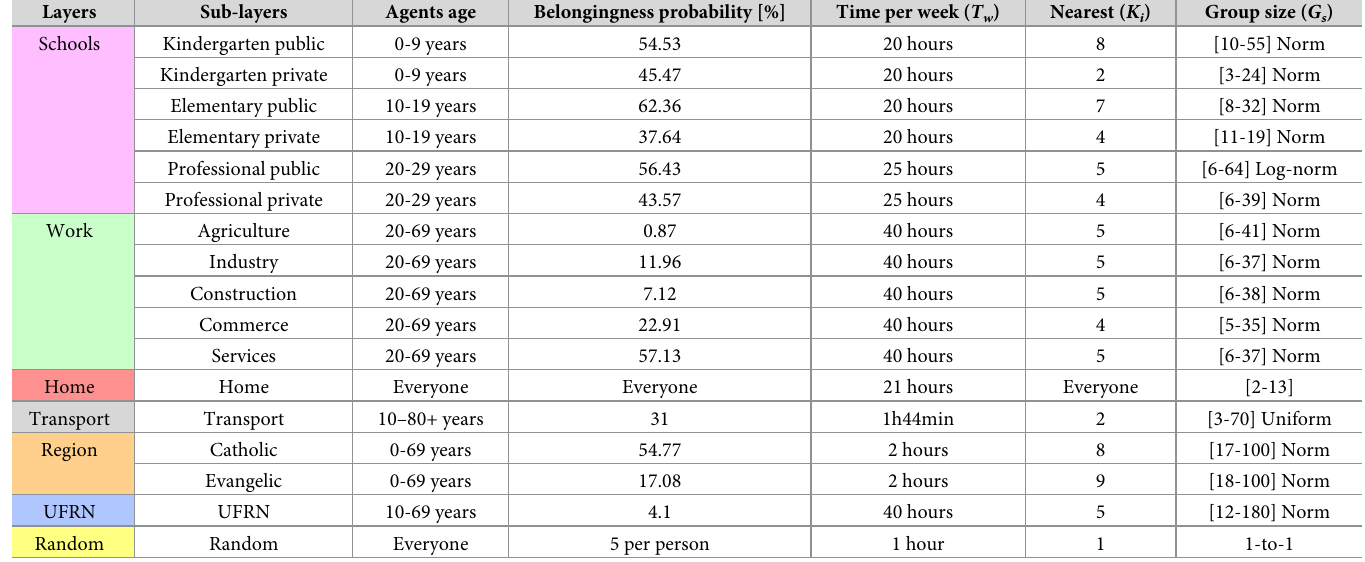
Table 3. Social interaction layers information. The first column (Layer) shows the layers (total of 7) implemented on the system, and sub-layers (schools, work and reli- gion), that further describe some of the activities (second column). The third column (Agents age) represents the age range distribution for each layer/sub-layer. The fourth column represents the probability of agents belonging to the layer. In some sub-layers (schools and work), the sum of this probability is 100%, which means that all agents within an age range must belong to only one of these sub-layers. The fifth column (Time per week) is the average time the agents spend interacting with other agents on this layer/sub-layer. The sixth column (Nearest) shows the agent’s average number of contacts per layer/sub-layer. The last column (Group size) represents the average group size and the agent’s distribution; per